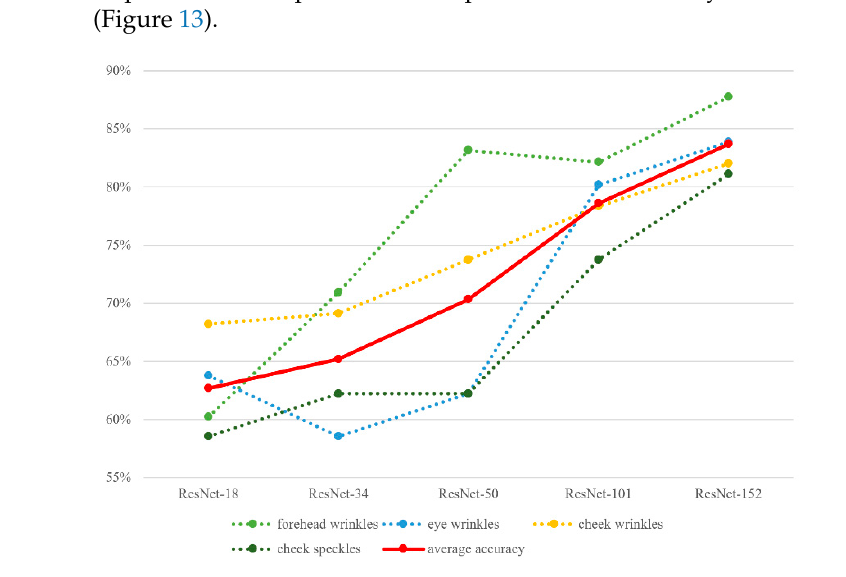
Figure 13. Model accuracy results (from K-fold cross validation) plotted against model layers and facial features.